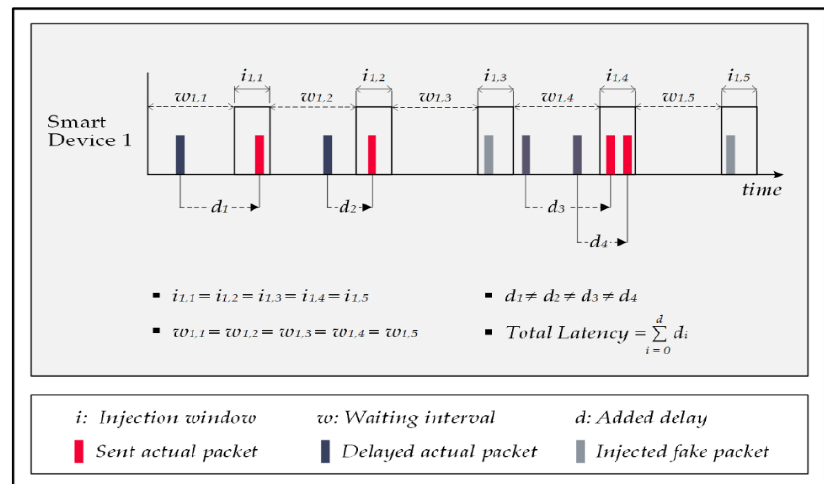
Figure 10. The ConstRate scheme.